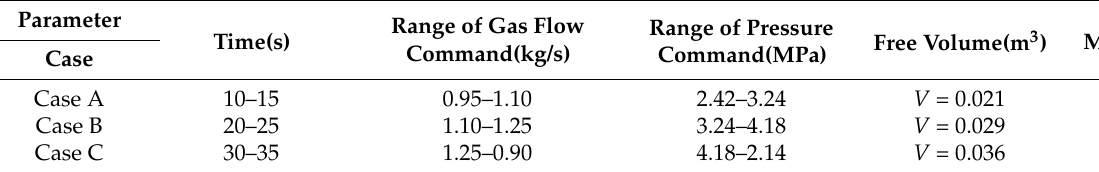
Table 2. Simulation commands.